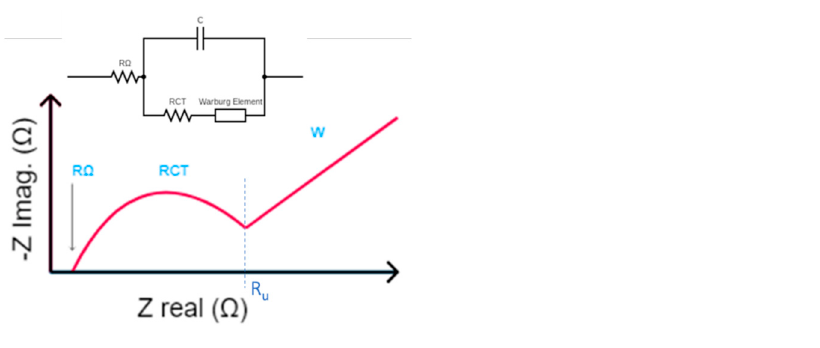
Figure 1. Equivalent Randle’s cell circuit model with Warburg element for EIS Nyquist plot fitting. A modified form of Archie’s law, Equations (3a) and (3b), were used to estimate the